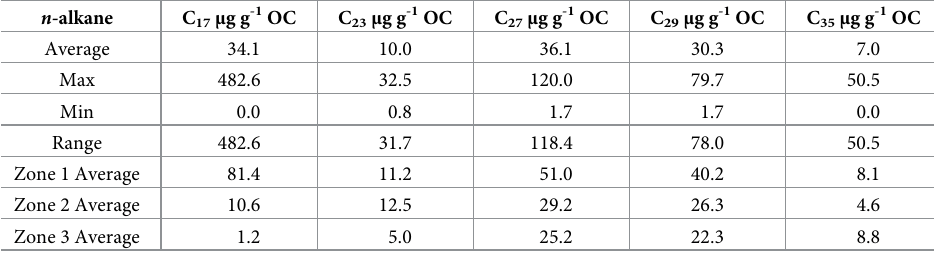
Concentrations (average, maxima, minima, and ranges) for the five n- alkane homologues used for organic matter source interpretation. Zones are delineated by δ 13 C TOC